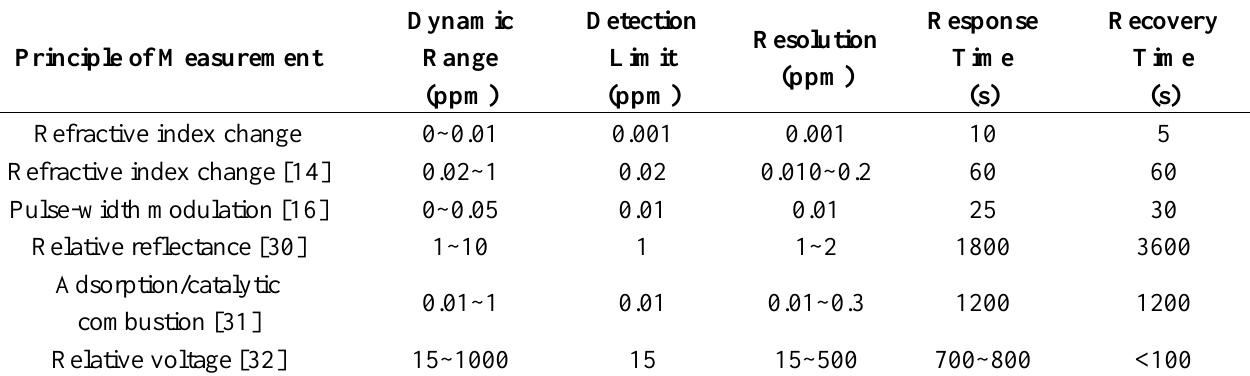
Table 1. Comparison of the analytical performance of similar VOC detection system.